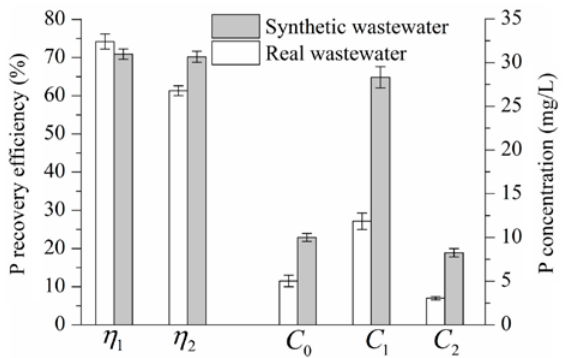
Fig. 4. P concentrations in the influent and effluent of IC column and its recovery efficiencies from synthetic and real